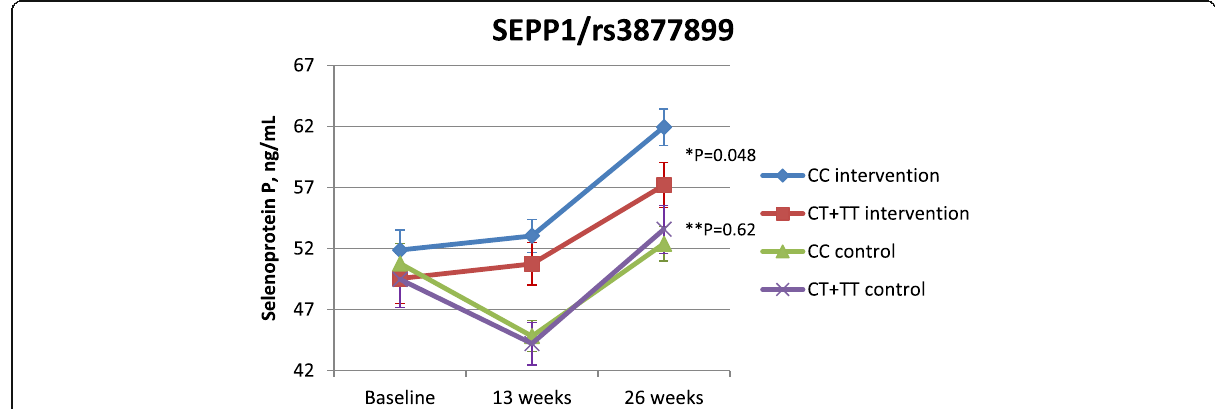
Fig. 2 Association between mean concentrations of selenoprotein P and the SELENOP/ rs3877899 polymorphism. Mean concentrations of selenoprotein P ± SD for the intervention and control group estimated by linear multiple regression adjusted for baseline level of selenoprotein P. P values for difference in mean selenoprotein P concentrations at week 26 for genotype effect within the intervention group (*) and within the control group (**), respectively, are